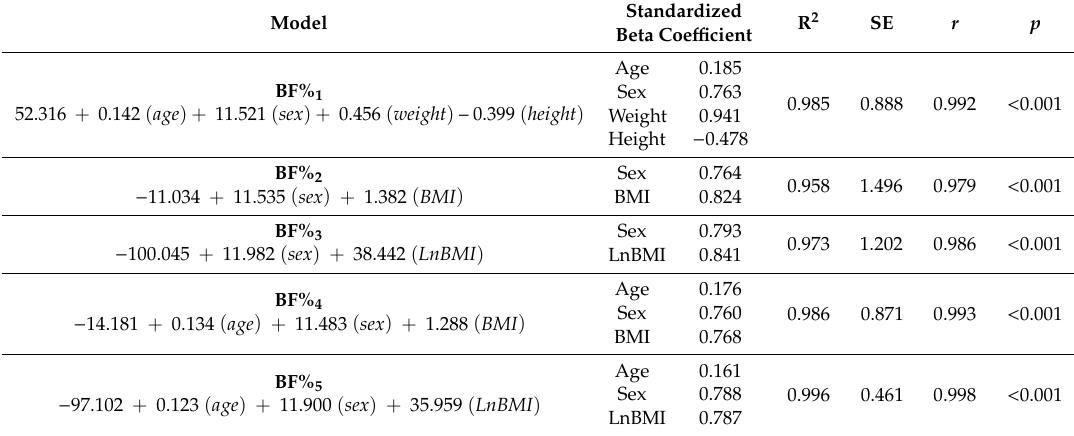
Table 4. Multiple linear regression models.